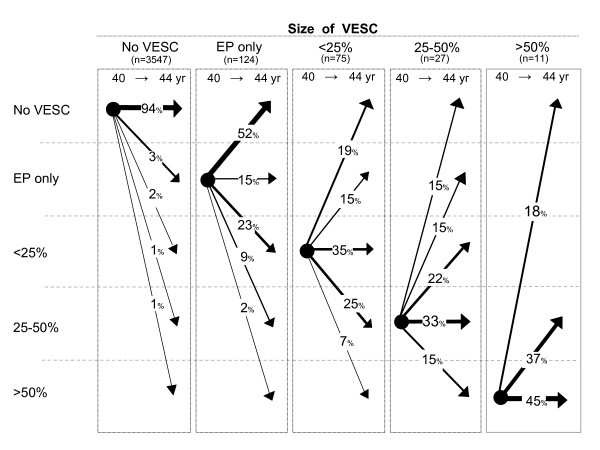
The natural course of VESC size. The natural course of VESC in relation to size of VESC in 3784 endplates from 344 persons from the Danish general population. Arrows indicate the change of VESC (in percent) from age 40 to age 44.